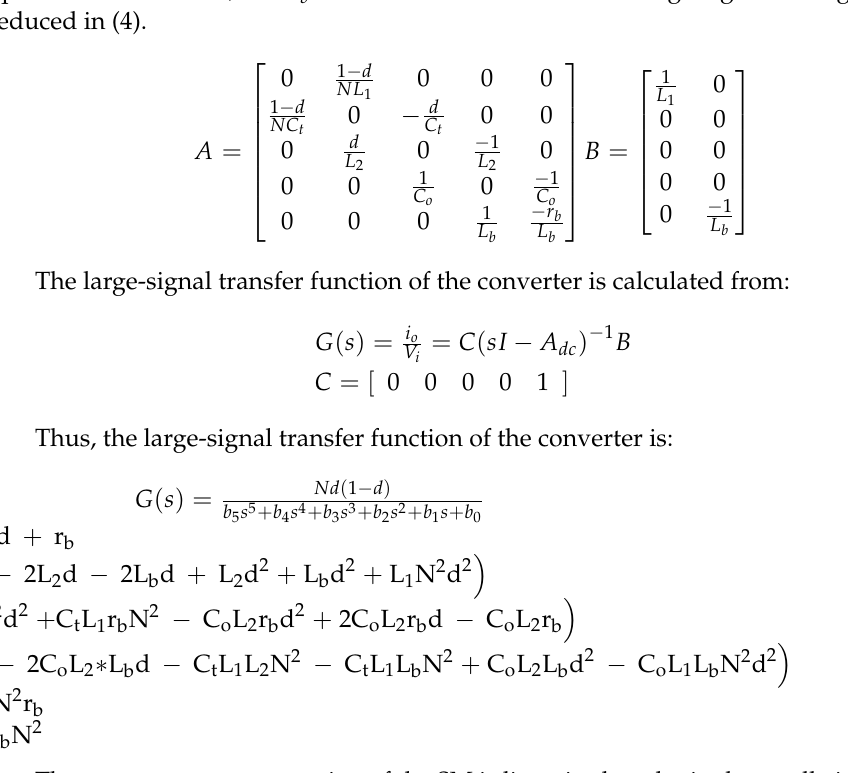
dc1 , ( b ) St dc2 , and ( c ) modulation